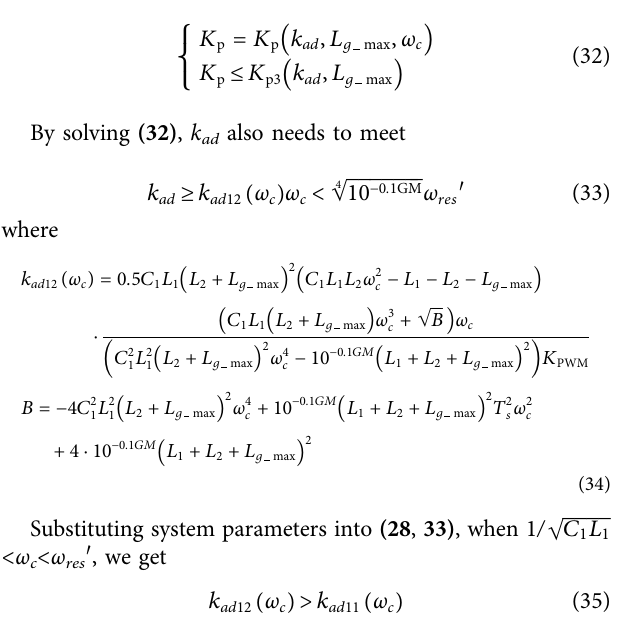
TABLE 2 | Parameters of the LCL grid-connected inverter.